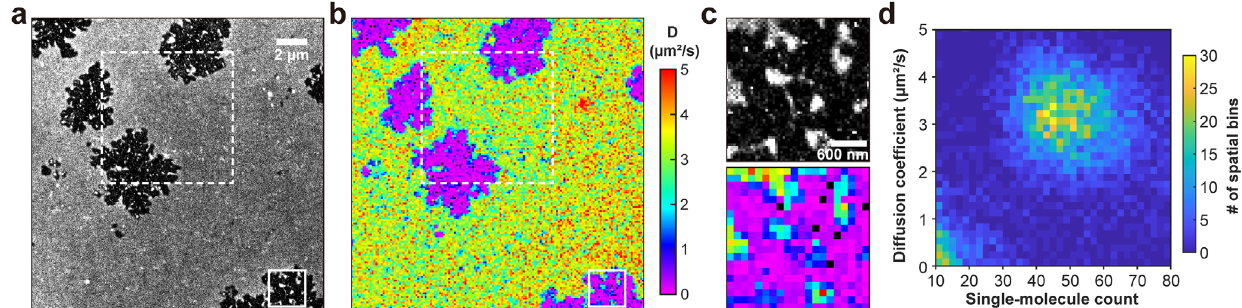
Fig. 4 Pix2D D mapping of SLB microdomains. a SMLM super-resolution image of an SLB of 60:40 DOPC:DPPC, presented as the local counts of single BDP-TMR-alkyne molecules recorded over 45,000 frames at 110 frames per second with an exposure time of 9 ms per frame. b Color-coded D map generated by spatially binning the single-molecule images onto a 120 nm × 120 nm grid for the Pix2D evaluation of local D . c Zoom-in of the solid box- marked region in a , b . d Two-dimensional distribution of the Pix2D-evaluated D versus single-molecule count for the different spatial bins in the dashed box-marked region in a , b